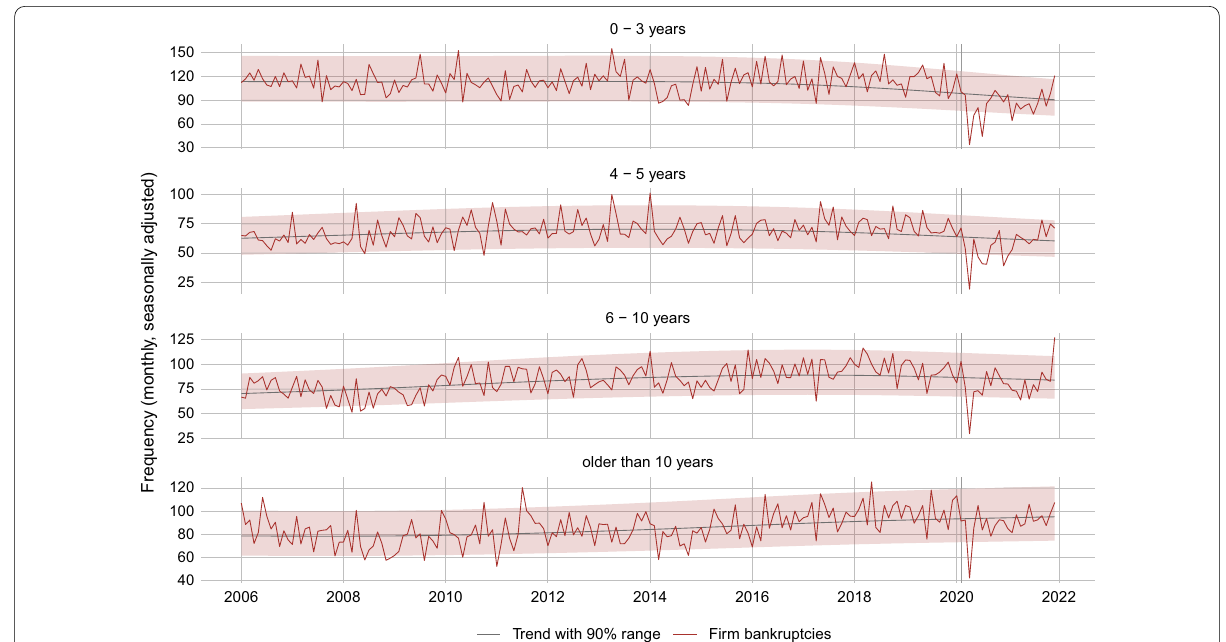
Fig. 8 Firm bankruptcies by age category. Notes : The figure shows the monthly seasonally adjusted frequency of total firm bankrupcties in Switzerland excluding SCO Art. 731b cases dissagragated by age category